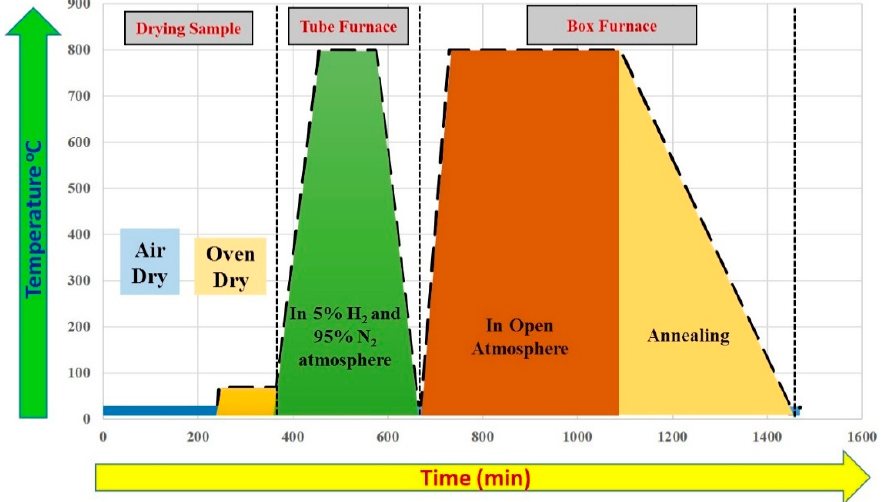
Figure 3. Temperature vs. time cycle of annealed samples after coating.